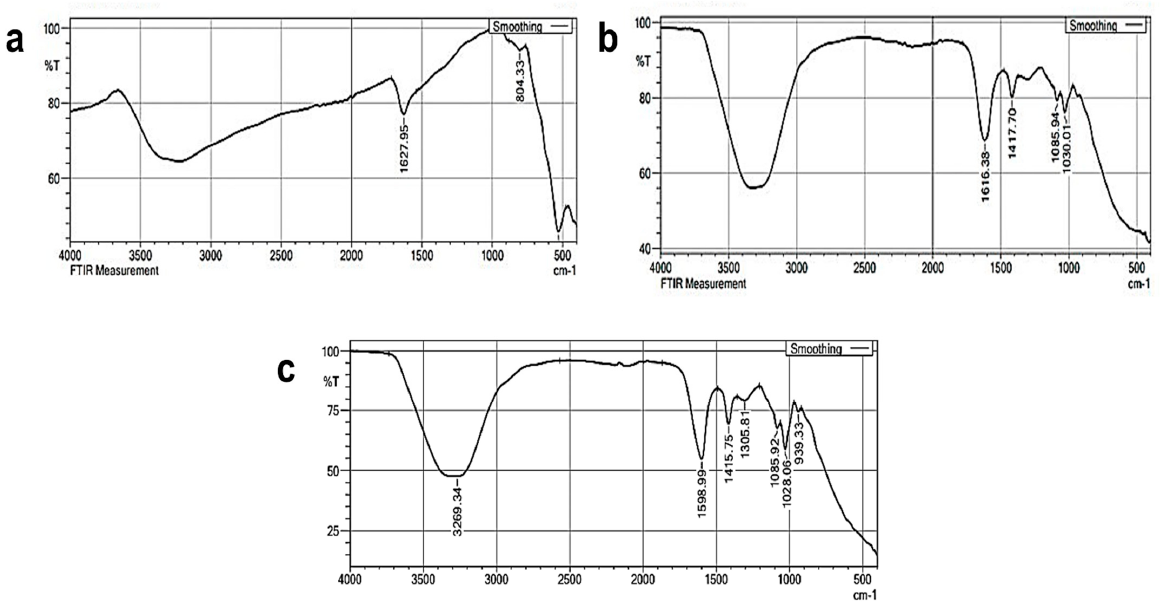
Toxics 2022 , 10 , x FOR PEER REVIEW 7 of 21 Figure 2. FTIR analysis of ( a ) SPIONs ( b ) Alginate beads ( c ) Alginate–SPIONs microspheres.